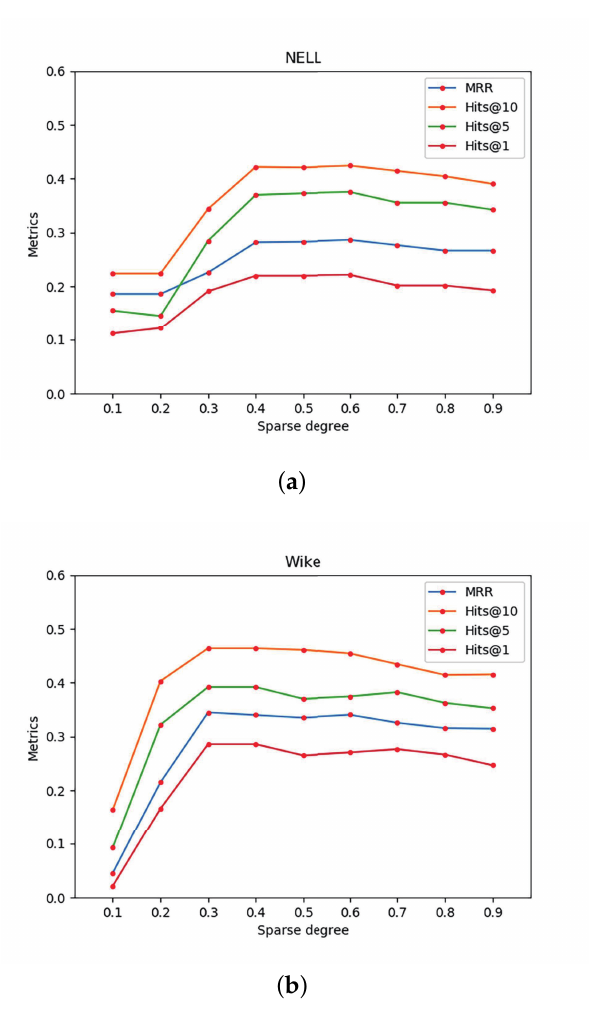
Figure 3. Line chart of model results with different sparsities. ( a ) The sparsity comparison result on the NELL; ( b ) The sparsity comparison result on the